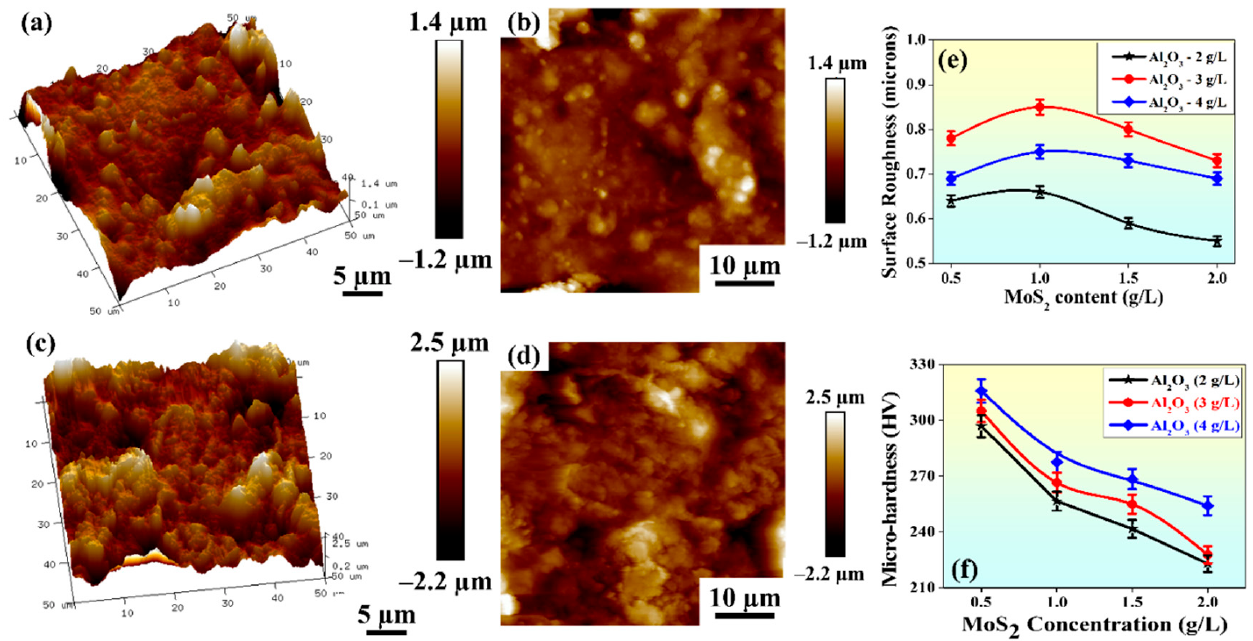
Figure 5. Atomic force microscopy images of the coated surface with ( a , b ) 4 g/L Al 2 O 3 and 2 g/L MoS 2 and ( c , d ) 3 g/L Al 2 O 3 and 1 g/L MoS2 powder content; variation of ( e ) average surface roughness; and ( f ) variation of micro-hardness with powder concentration.